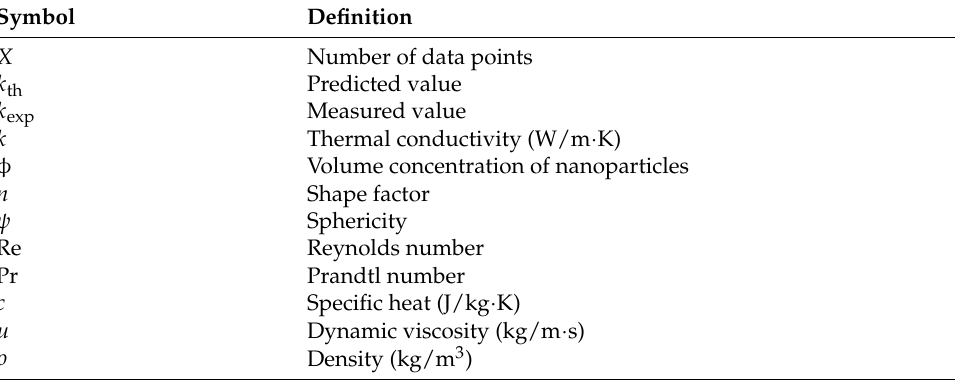
Table A1. Nomenclature with standard units. Note that many models use other units for